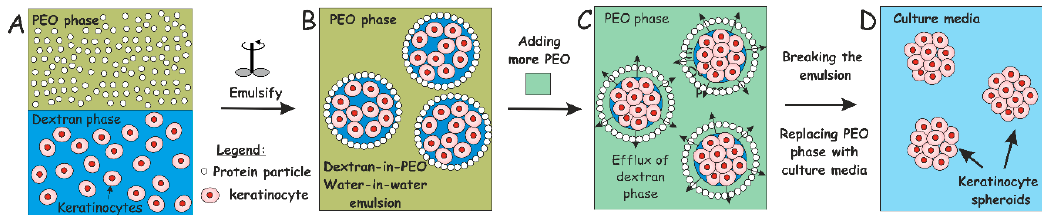
Figure 1. Schematics of our high-throughput method for preparation of keratinocyte cell spheroids ( A – D ). The keratinocyte cells are encapsulated in a dextran-PEO water-in-water emulsion template stabilised by 2 wt% WP particles. The continuous phase is PEO 5.5 wt% and the dispersed phase is composed of cells encapsulated in dextran droplets. Upon emulsification, cells prefer the discontinuous dextran phase, which allow their encapsulation. Adding more concentrated PEO phase causes osmotic shrinking of the cell-rich dextran drops, whose interfacial tension packs the cells into tissue spheroids. The latter are isolated by breaking the emulsion by dilution with culture media.